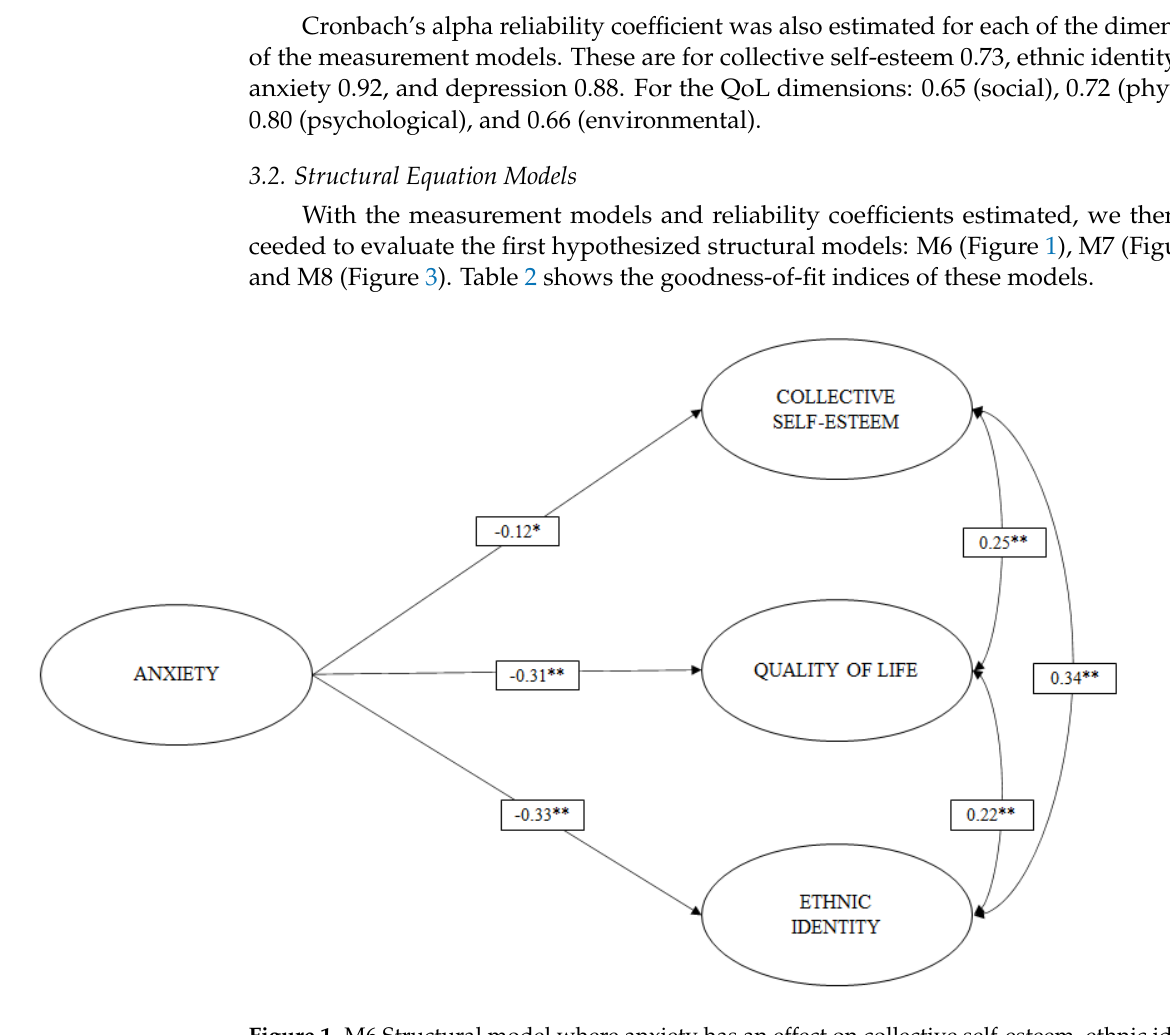
Table 2. Indicators of overall fit of the estimated structural models.